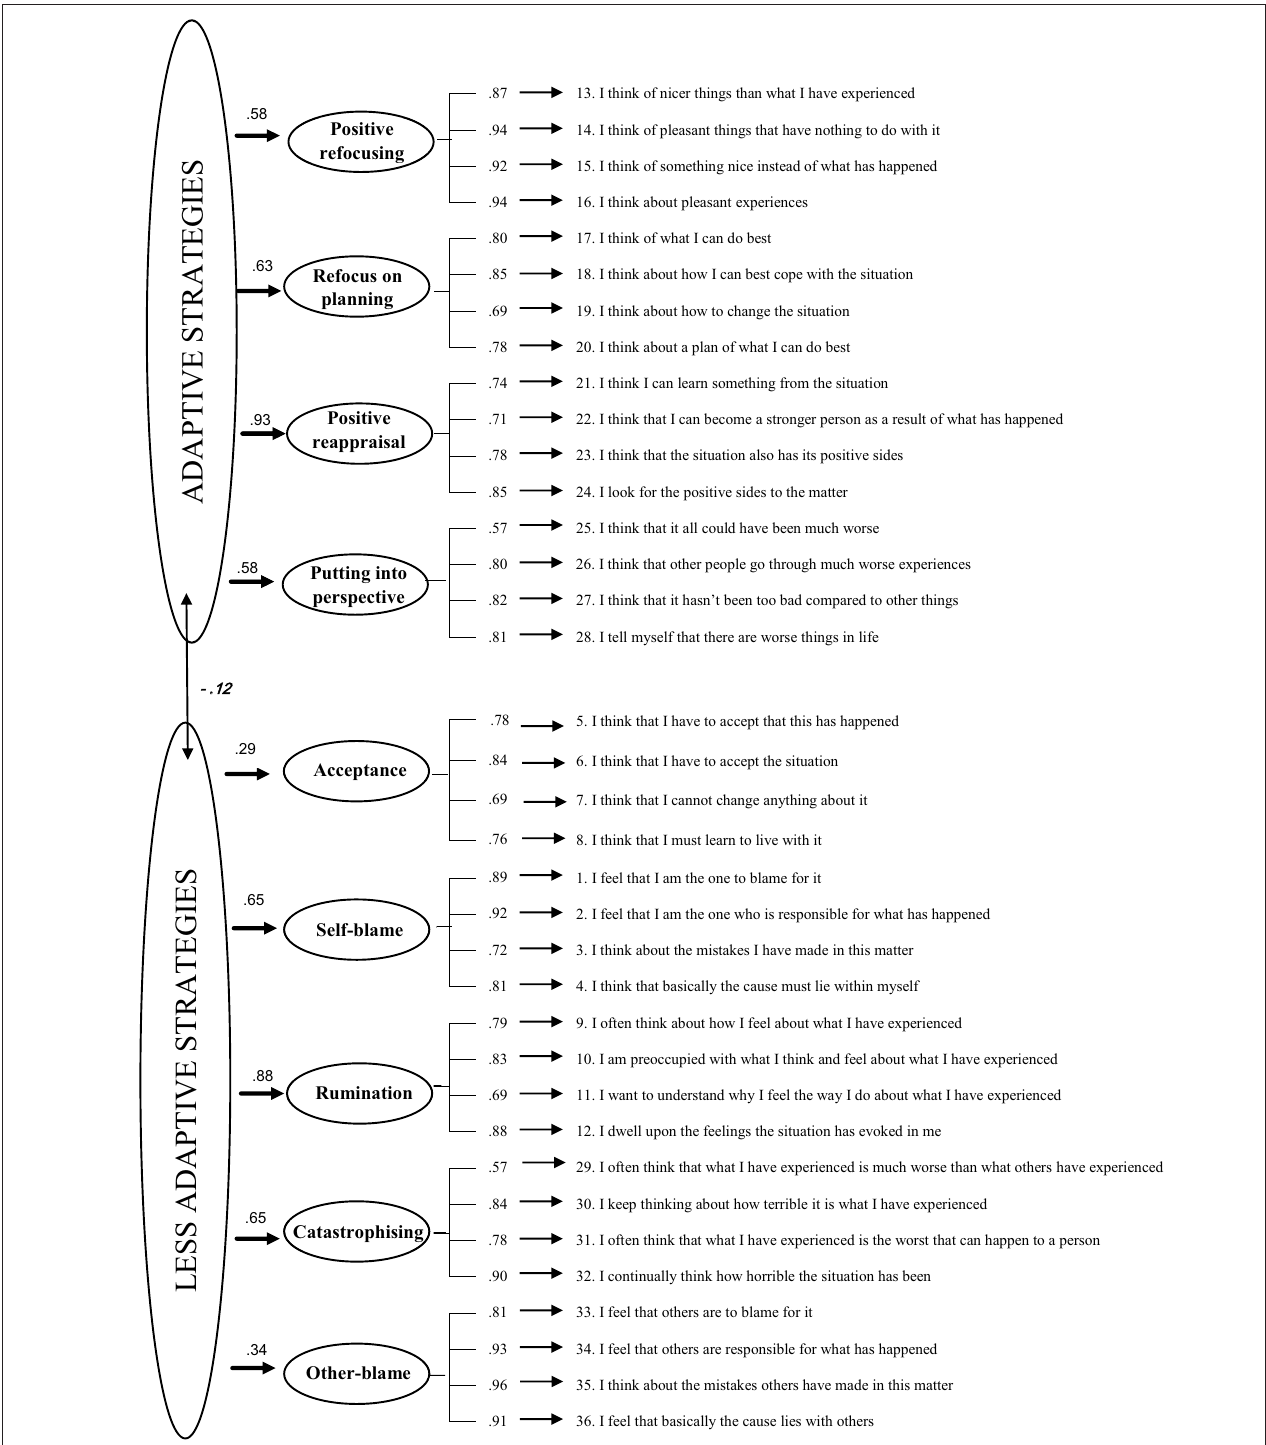
FIGURE 1 | Standardized factor loadings in the hierarchical model with Acceptance as part of the “less adaptive” strategies second-order factor. Non-significant values are given in Italics.